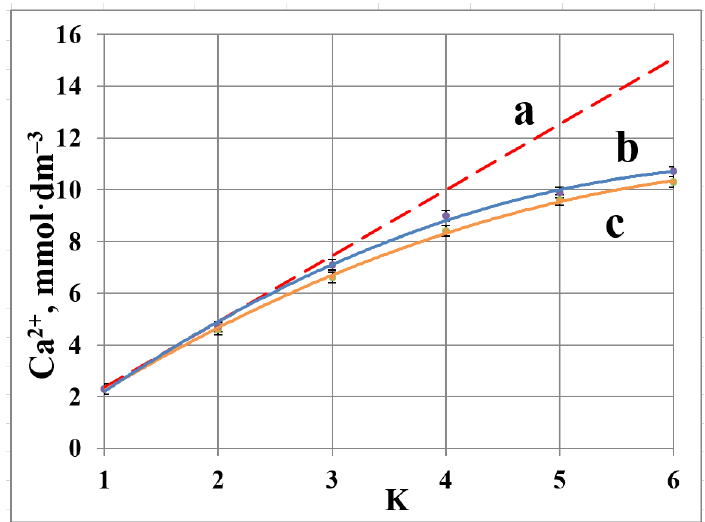
Table 3. Variation of calcium concentration and pH in retentate.